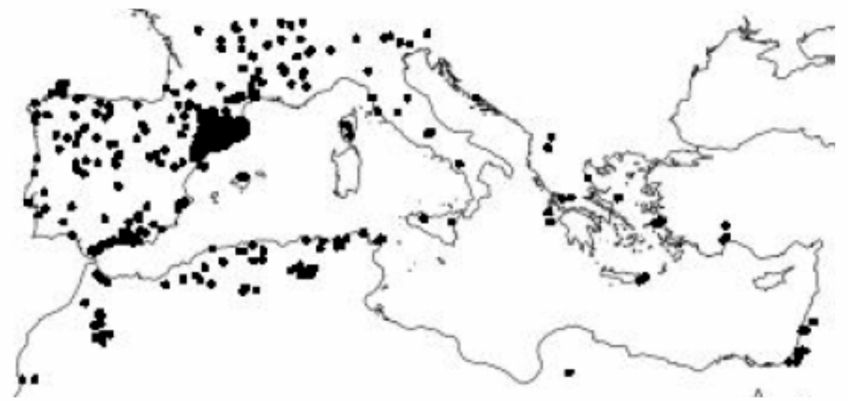
Figure 1. Sites with observational/experimental data used in this